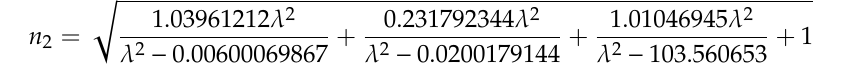
Table 1. The monolayer and refractive index (RI) of Blue Phosphorene (BlueP)/transition metal dichalogenides (TMDCs) and graphene at λ = 632.8 nm. BlueP/TMDCs and Graphene Monolayer (nm)